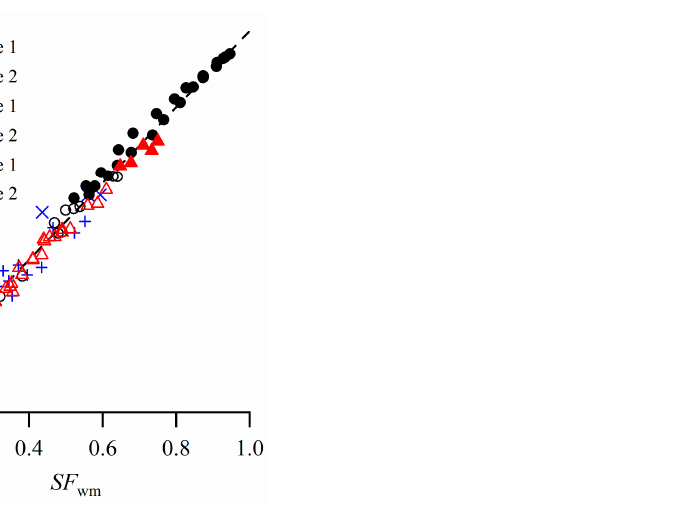
Figure 5. Comparisons of the measured data and the calculated results for composite roughness cases.